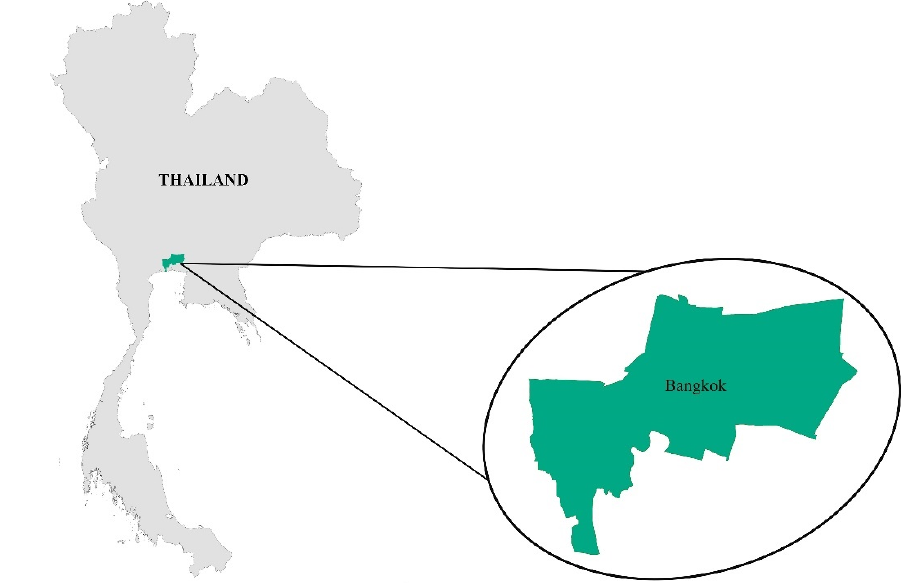
Figure 1. Research case study, Bangkok, Thailand.